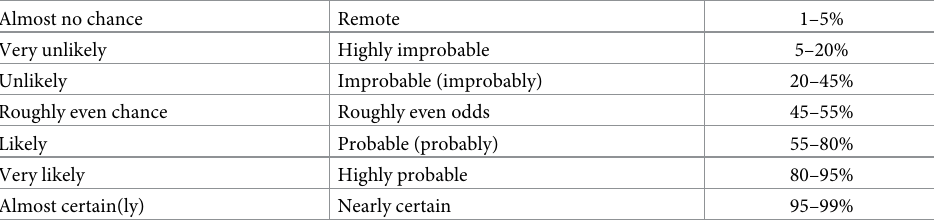
Table 1. Linguistic probability expressions and numeric range equivalents in